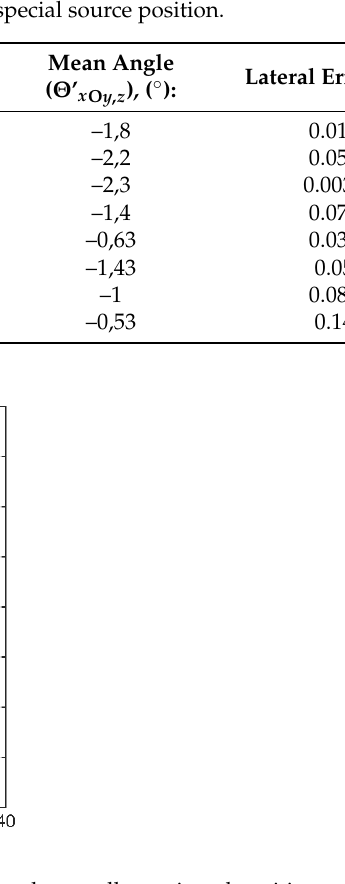
Figure 11. Absolute lateral error versus observation angle α at all mentioned positions of the source from Table 3.